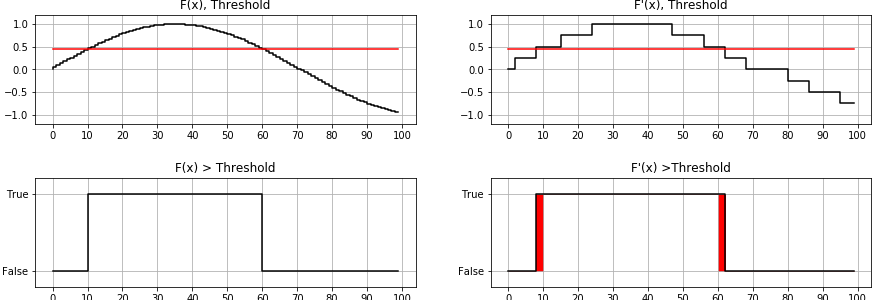
Figure 4. Upper left : Original signal F ( x ) , in black; and a constant threshold (Threshold), in red. Bootom left : Boolean response of the condition ( F ( x ) > Threshold) applied to the original signal and threshold. Upper right : Reduced signal F (cid:48) ( x ) , in black; and a constant threshold (Threshold), in red. Bootom left : Boolean response of the condition ( F (cid:48) ( x ) > Threshold) applied to the reduced signal and threshold. In red, Boolean variations with the obtained in the bottom left